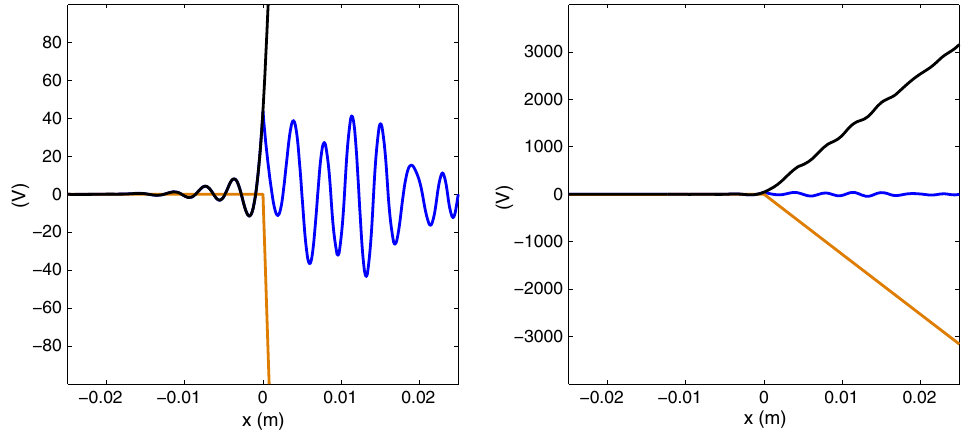
ˆ E ξ Re u of Eq. (54) for the case of Fig. 5, on two different scales. The black curve is Re u yp ¼ E þ E ˆ E (equal to Re u yp